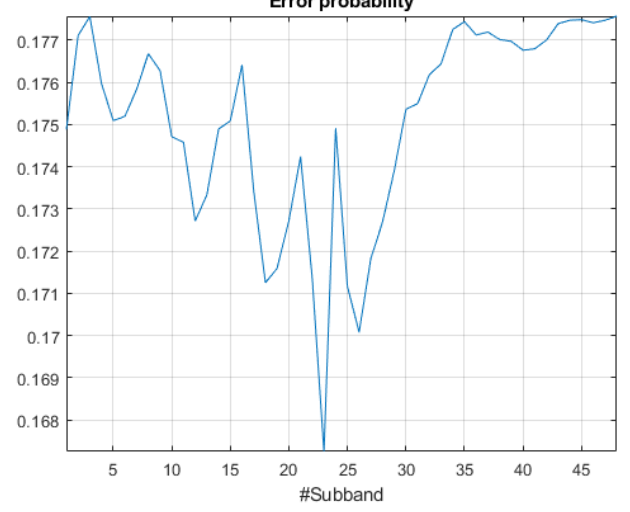
Figure 6. Error probability analysis for suburban recordings data.